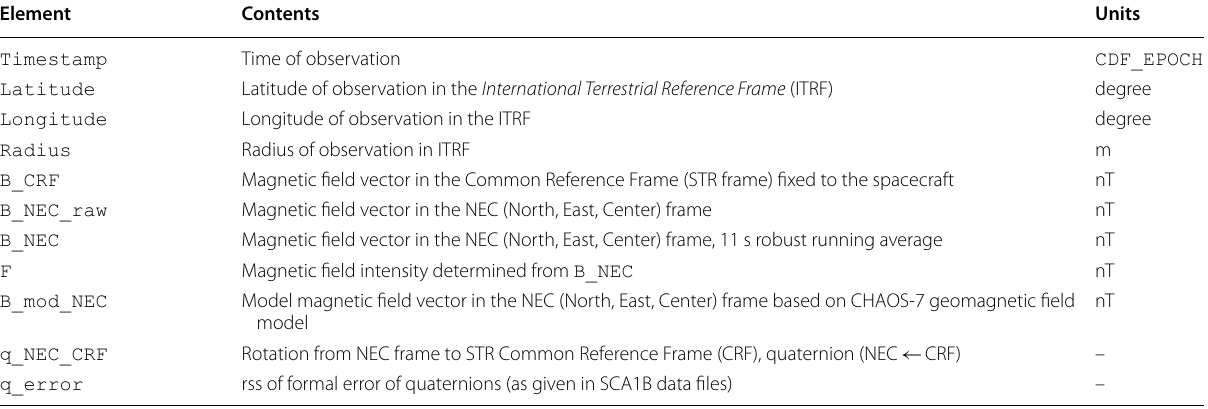
Table 3 Content of the calibrated GRACE magnetic data product